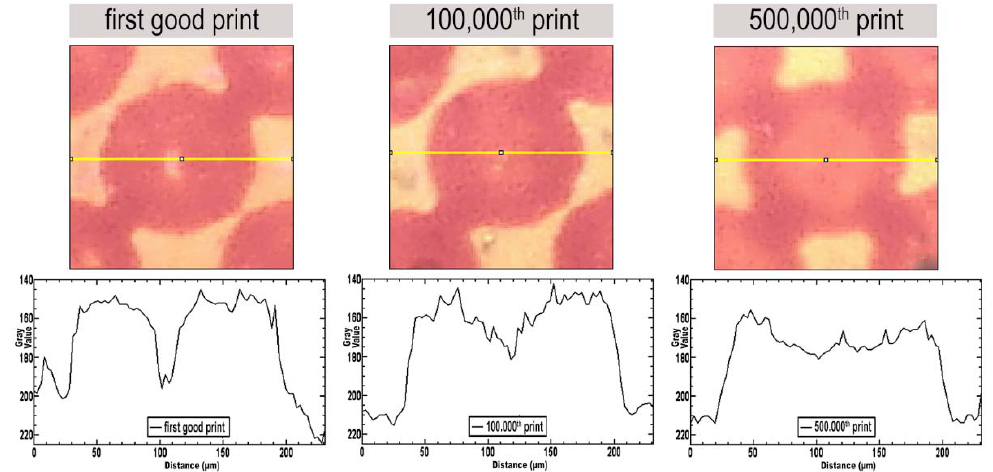
Figure 8. 2D dot profile in three stages of printing.